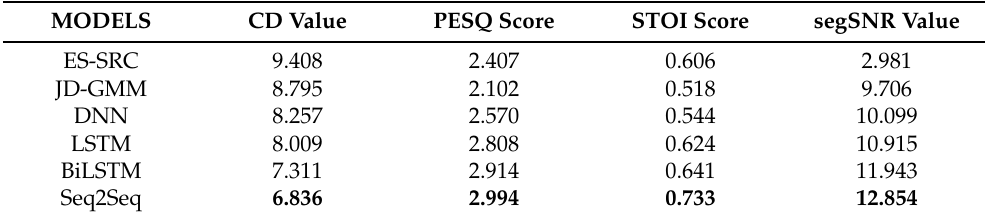
Table 1. Results of the objective assessment of the reference and proposed methods on the PC speaker esophageal corpus test set.